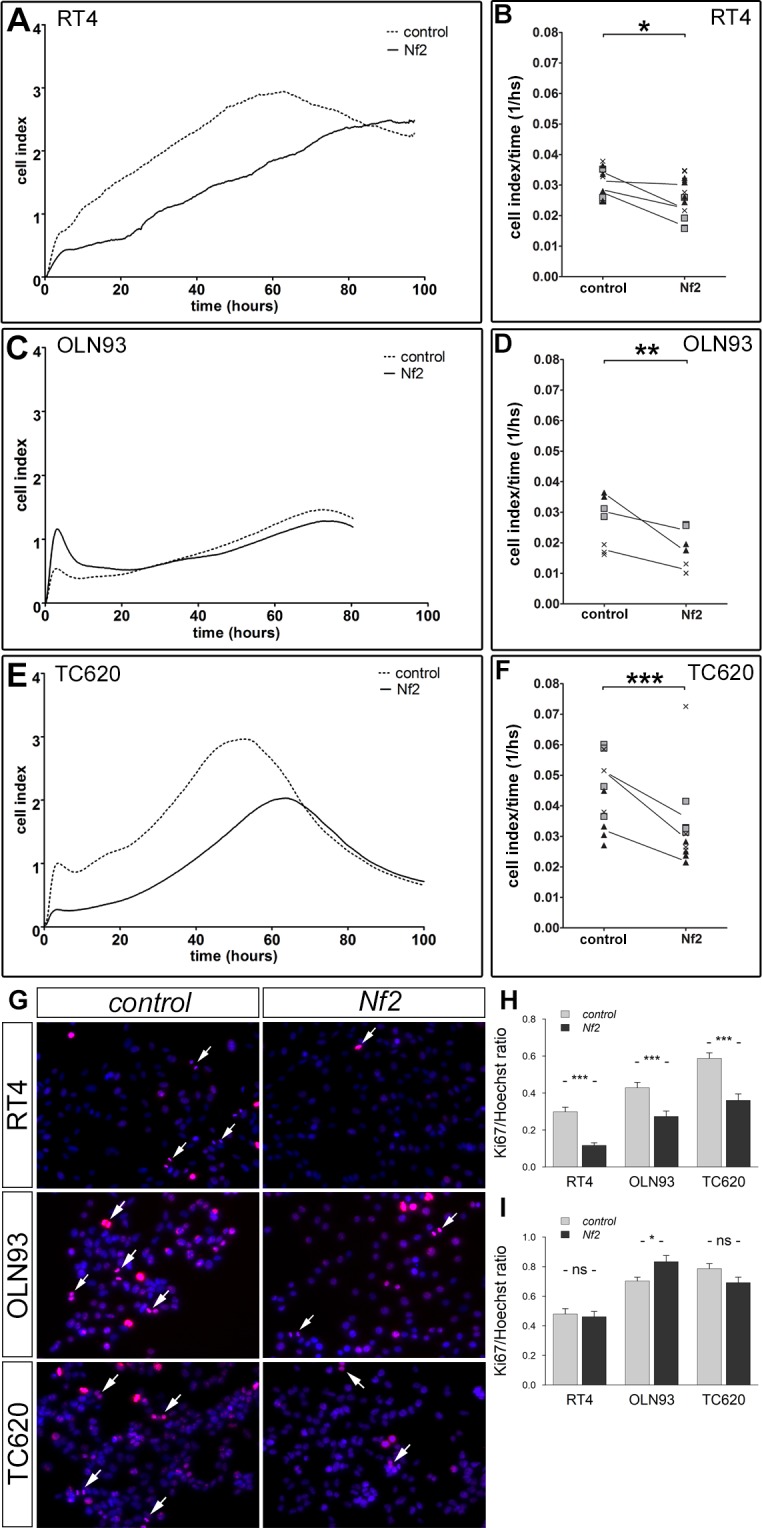
Merlin expression affects cell impedance in XCELLigence measurements.Cellular impedance was measured in RT4 (A, B), OLN93 (C, D) and TC620 cells (E, F), over-expressing Nf2 and in control cells by XCELLigence. The cell index given as a measure of impedance of adhered cells, demonstrated a similar curve in all cell lines (A, C, E). Comparing cell indices over time by evaluating slopes of curves revealed a significant drop in Nf2-transfected (solid line) as compared to the control-transfected cells (dashed line) (B, D, F). Same symbols stand for replicates of one experiment. Lines connect corresponding average values of replicates within a single experiment. Significance values were calculated using the Wilcoxon signed rank test for independent samples (*p < 0.05; **p < 0.01; ***p < 0.001). Pictures in G represent typical images of Ki67 stainings (red). Mitotic figures are depicted by arrows. Total numbers of cells were visualized by Hoechst staining (blue, bar 10 μm). The relative Ki67/Hoechst staining was significantly decreased in Nf2-transfected versus control-transfected cells at 48 and more hours (H), but it was unchanged at shorter time periods (I, ns non-significant).